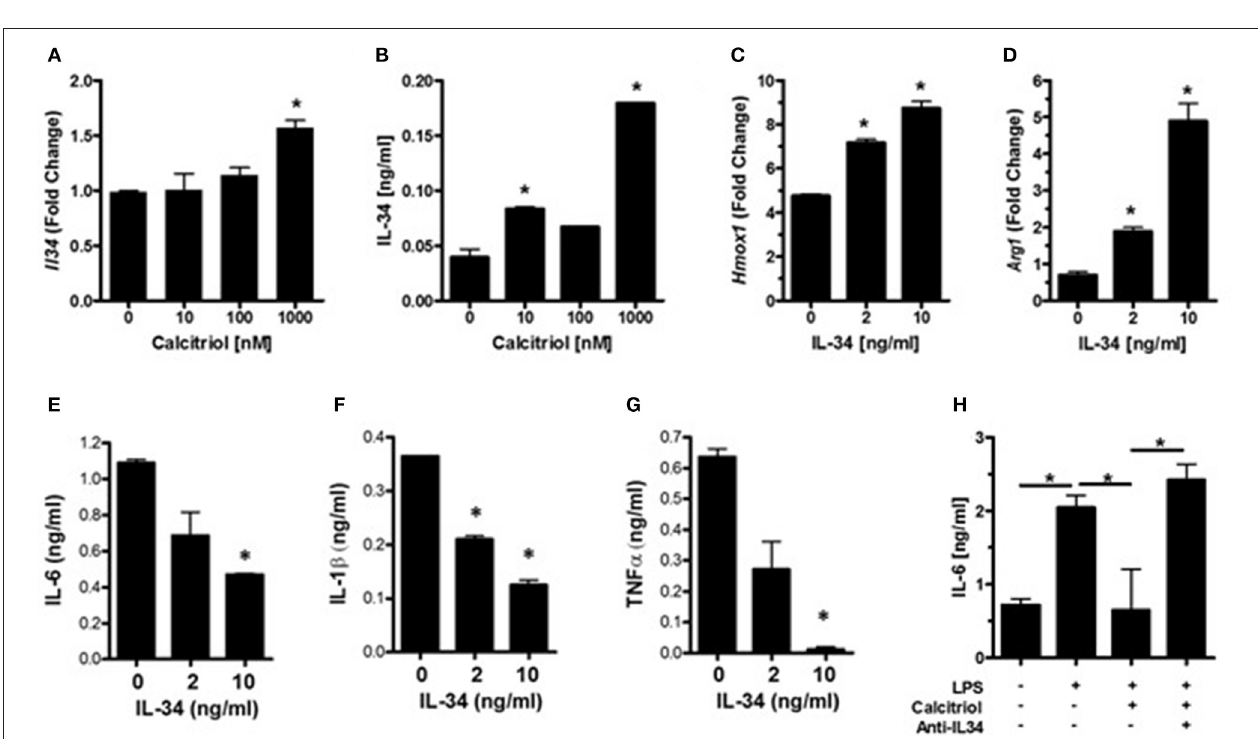
FIGURE 3 | Vitamin D induces IL-34 in neurons, and IL-34 induces an anti-inflammatory phenotype in microglia. (A) IL34 transcripts were measured by real-time PCR in primary neurons treated with calcitriol. (B) IL-34 was measured by ELISA in the supernatants of primary neurons treated with calcitriol. Hmox1 (C) and Arg1 (D) transcripts were measured by real-time PCR in primary microglia treated with IL-34 and activated with LPS. IL-6 (E) , IL-1 β (F) , and TNF α (G) were measured in the supernatants of primary microglia treated with IL-34 and activated with LPS. (H) NCM from calcitriol-treated primary neurons was treated with anti-IL34, transferred to primary microglia, and IL-6 was measured by ELISA. * p <